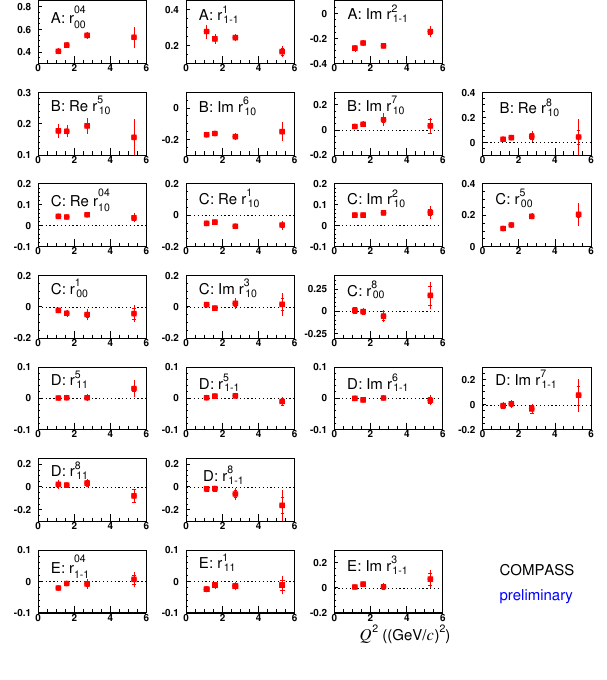
Figure 4: The dependences of SDMEs on Q 2 . The SDMEs were divided into five classes the same as in Fig. 3.